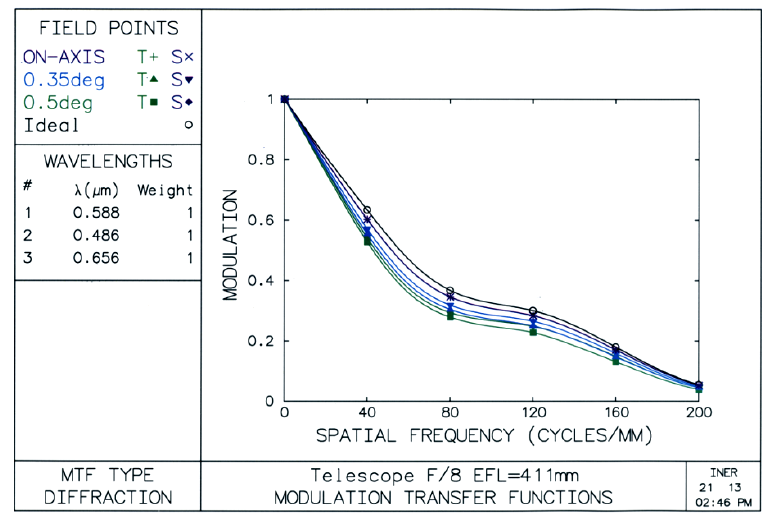
Figure 2. MTF analysis of a reflecting type Cassegrain telescope.